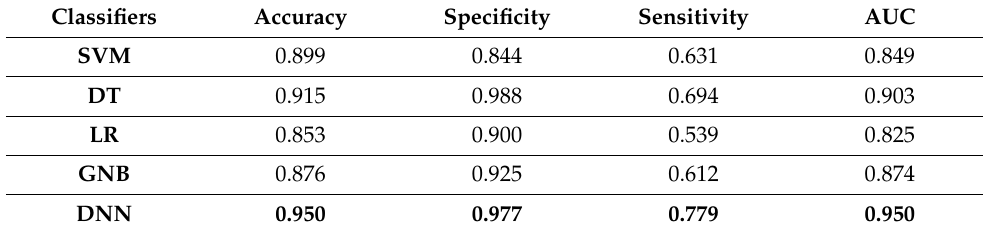
Table 3. Test evaluation metrics of a dataset for different classifiers with image block size 32 × 32.